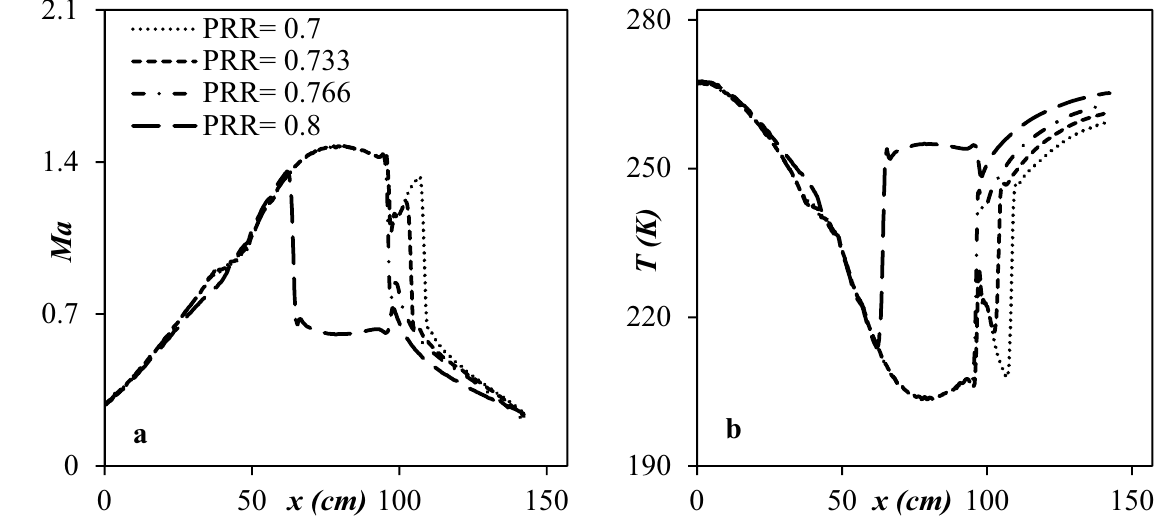
Figure 16. The influence of PRR on the shockwave position for ( a ) Ma number and ( b ) Temperature.